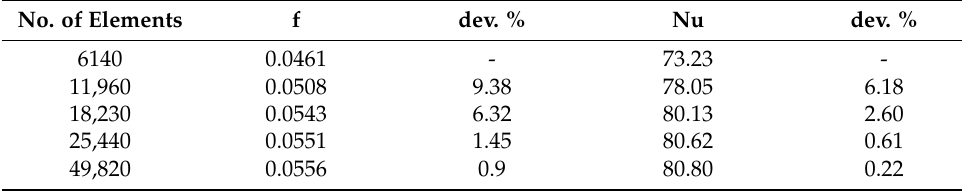
Table 4. Grid independent test for Re = 18650 and insert diameter D = 0.4. No. of